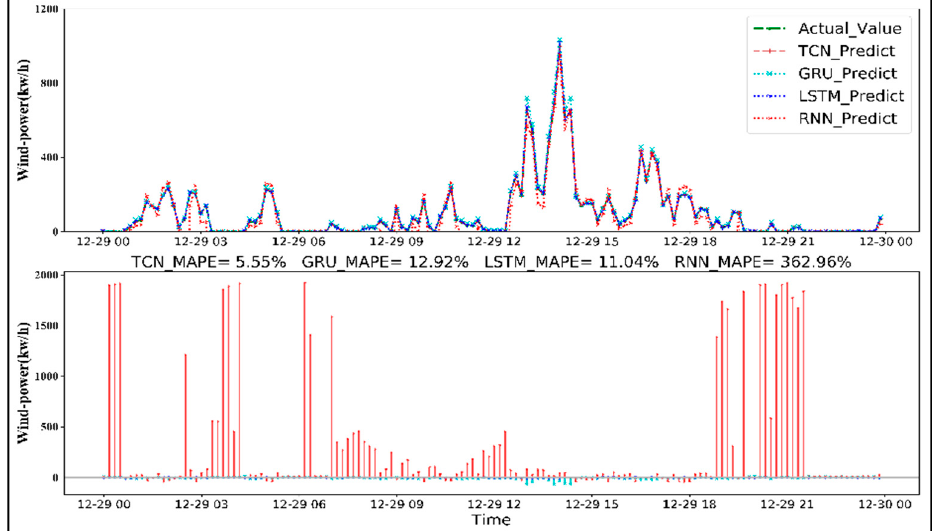
Figure 12. 24-h wind power forecasting (Experiment II).